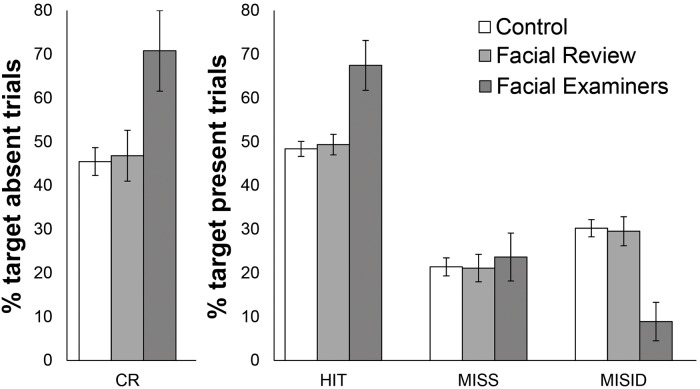
Face matching performance of participant groups in Experiment 2.Performance is expressed as correct rejection (CR), hit, miss and misidentification (MISID) rates. Error bars denote standard error.